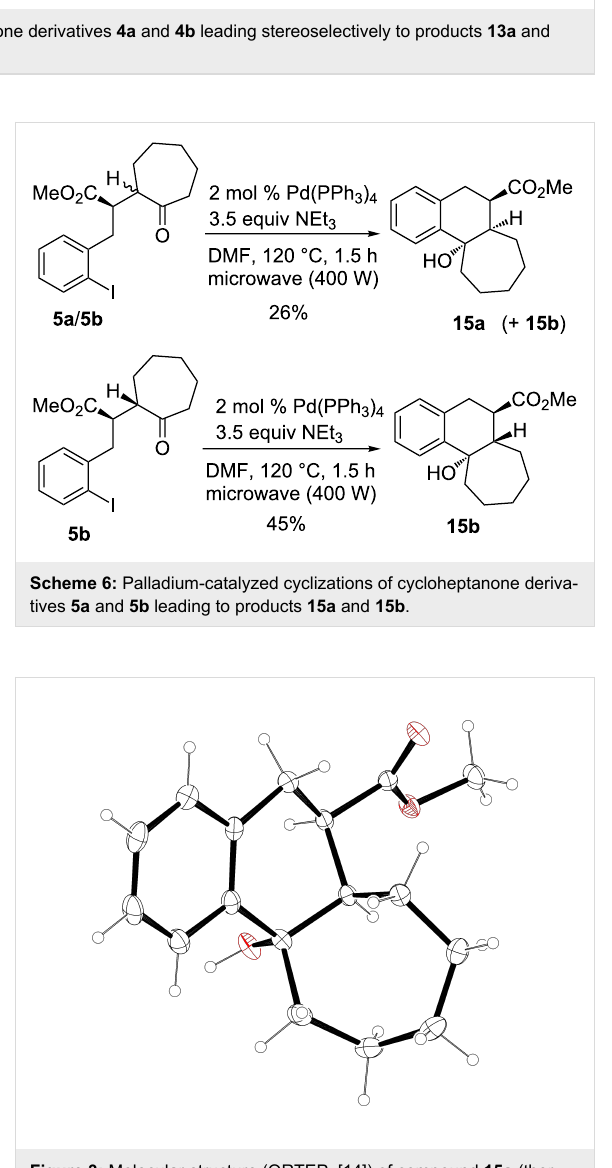
Figure 3: Molecular structure (ORTEP, [14]) of compound 15a (ther- mal ellipsoids at 50%